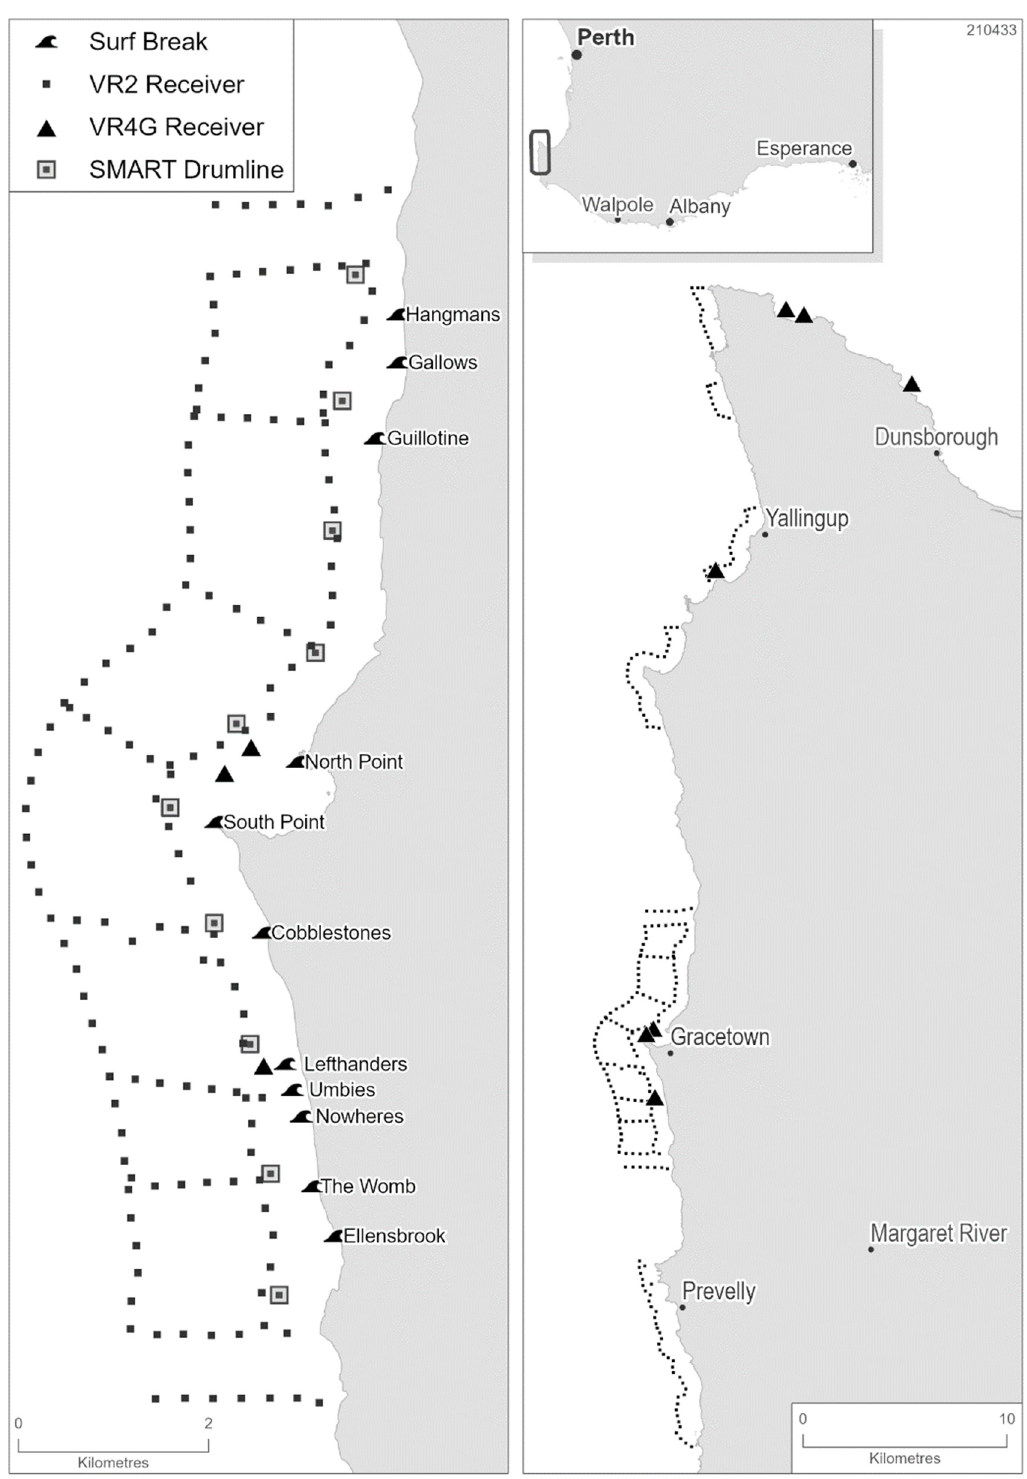
Figure 1. Map of the Capes region of Western Australia highlighting the 10 fixed locations where SMART drumlines were deployed and the locations for the VR2 and VR4G or Rx LIVE receivers. Left panel displays the location of the drumlines in relation to popular surf breaks and the receivers within the Gracetown array. Right panel displays the primary and secondary receiver arrays and the location of the Capes region in relation to the state capital of